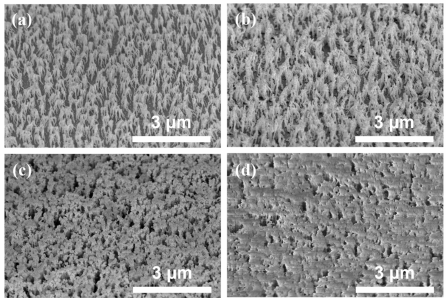
Figure 5. Cross-sectional (tilt angle of 45 ◦ ) SEM images of diffusion layer: ( a ) RNSs 1-3, ( b – d ) TiO 2 - diluted RNSs 1-3-1, 1-3-2, and 1-3-3 (1.0, 4.0, and 8.0 wt%,